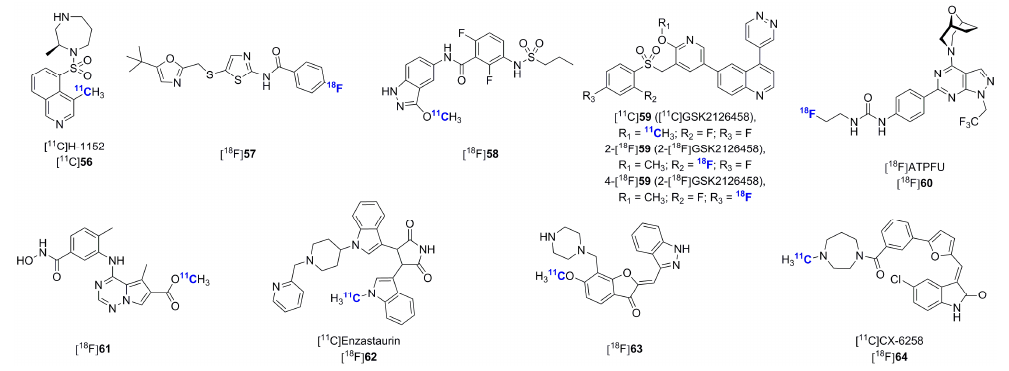
Figure 16. Chemical structures of recently synthesized serine/threonine kinase inhibitors.